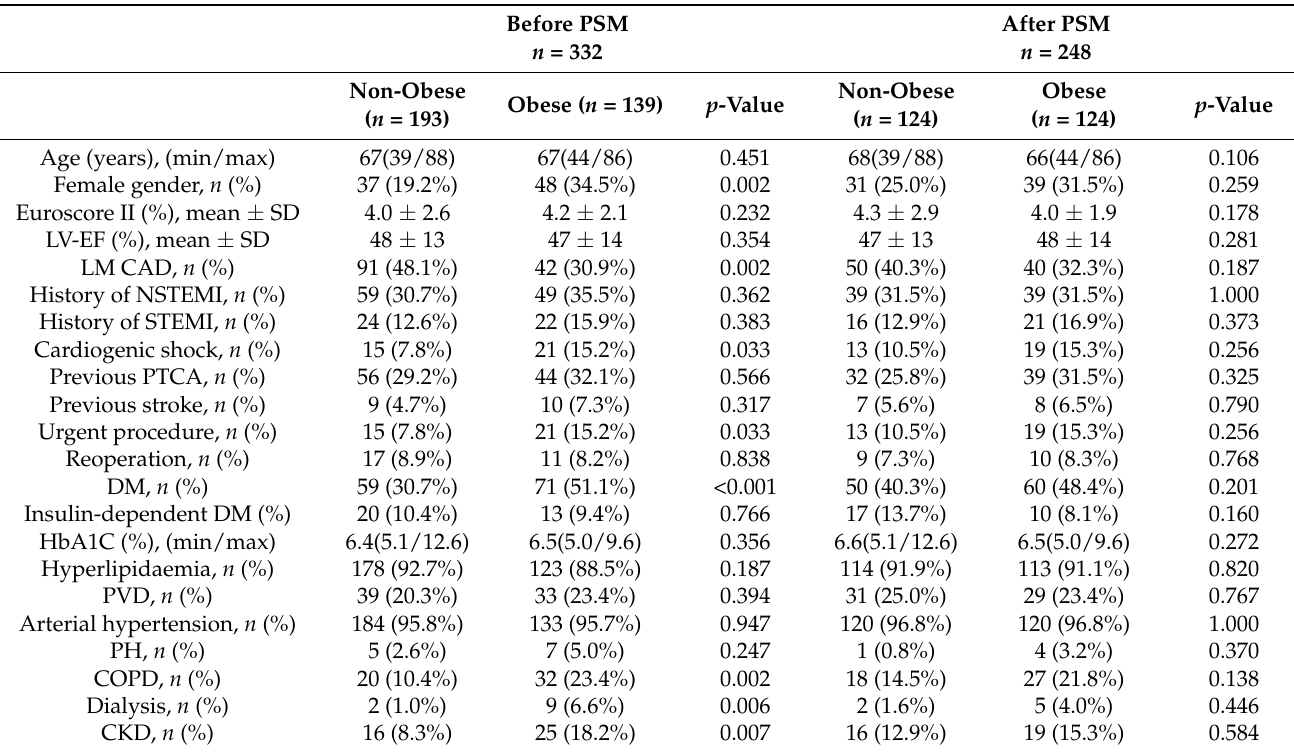
Table 1. Patients’ baseline preoperative